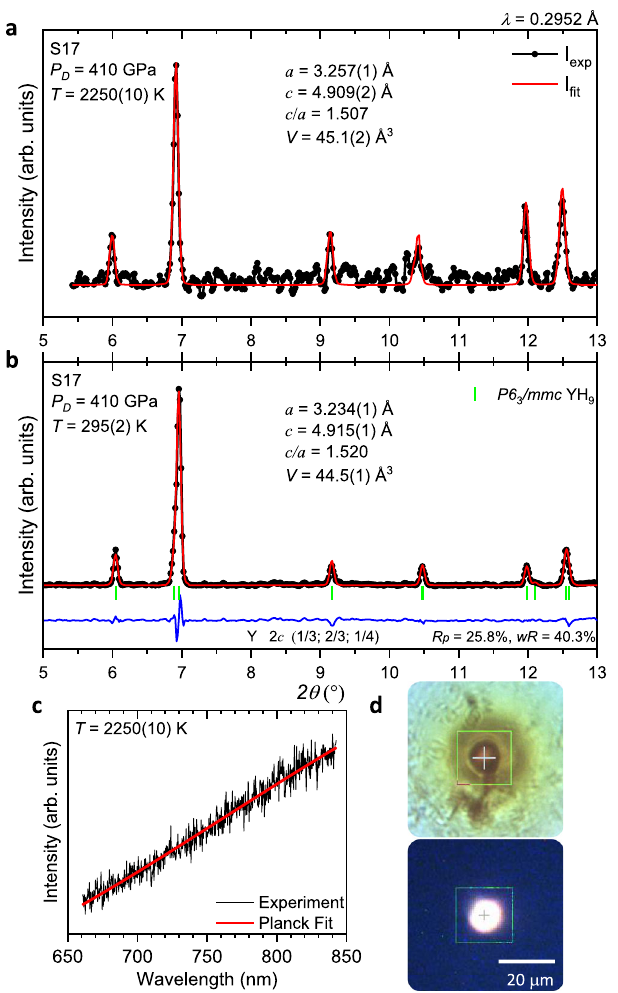
Fig. 3 X-ray diffraction study of the yttrium-hydrogen system at extreme pressure and temperature conditions. a X-ray powder diffraction pattern collected from sample 17 (S17) (YH 3 + NH 3 BH 3 ) at 410GPa directly at the moment of pulsed laser heating at 2250(10) K (black circles) and Le Bail re fi nement (red curve). b X-ray powder diffraction pattern of sample 17 at 410GPa after subsequent quenching to ambient temperature, corresponding to the pure P6 3 /mmc YH 9 phase. Black circles, red and blue curves correspond to the experimental data, Rietveld re fi nement fi ts and residues, respectively. Green ticks indicate the calculated peak positions for the P6 3 /mmc YH 9 phase. c The thermal radiation spectrum measured during pulsed laser heating (black curve) and the fi t to Planck ’ s radiation law (red curve). d Photos of the sample at ambient temperature (top) and during pulsed laser heating